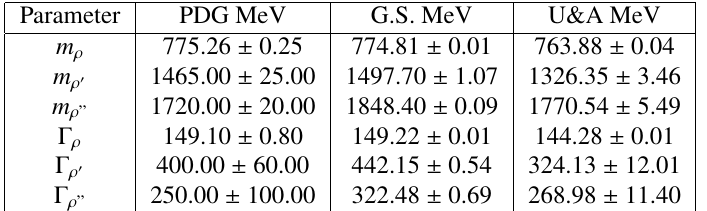
Figure 4. Phase shifts and squared modules of amplitudes produces by single poles from Table 1 and their pairs, black lines are for pole 2, blue for 2’ and red for both poles together. Table 2. Parameters of ρ states obtained using Gounaris-Sakurai model and unitary and analytic approach are compared with values from Particle Data Tables